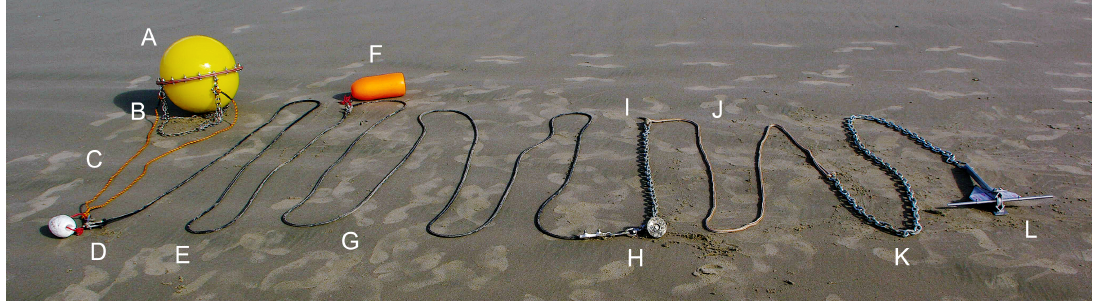
Figure 3. The wave measurement buoy and anchor line developed for the research project are shown laid out on Agate Beach. (A) buoy, (B) damping chain, (C) bridle, (D) bridle float, (E) rubber cord, (F) surface float, (G) rubber cord, (H) sinker, (I) chain, (J) nylon line, (K) anchor chain, (L) drag